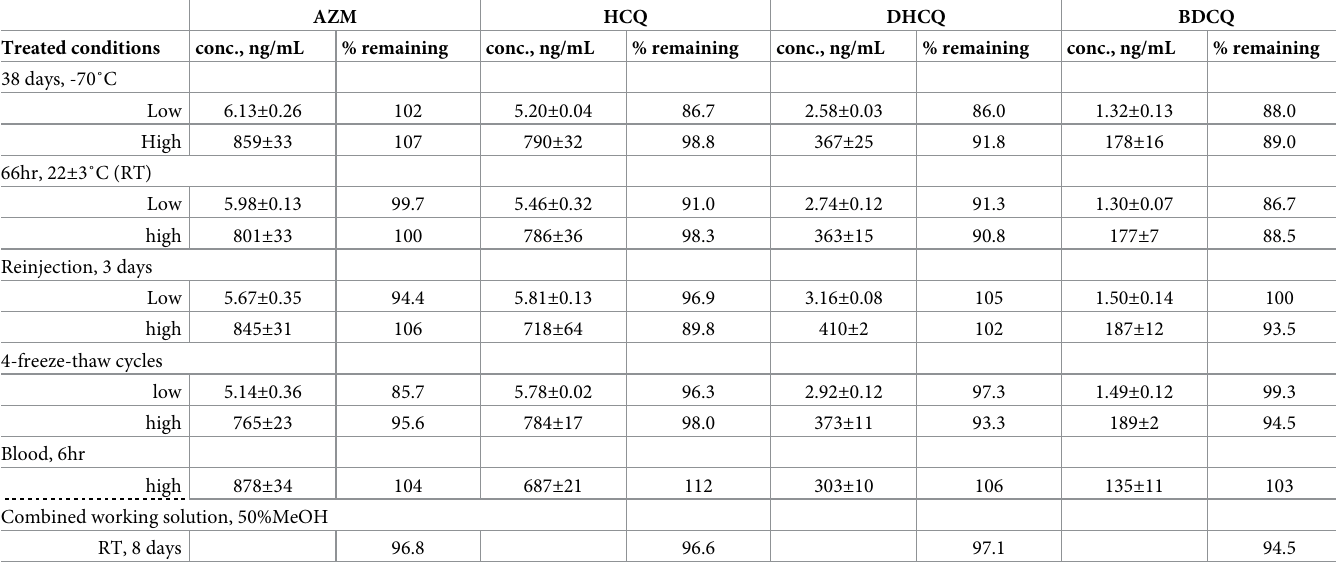
Table 5. Stability of AZM, HCQ, DHCQ, and BDCQ (n = 3).